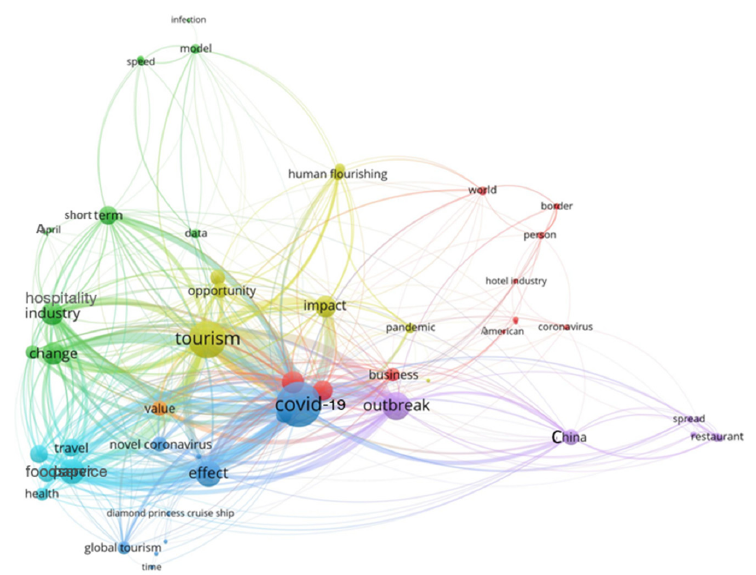
Figure 3. The map of the co-occurrence of the terms in the title and abstract of recorded papers.